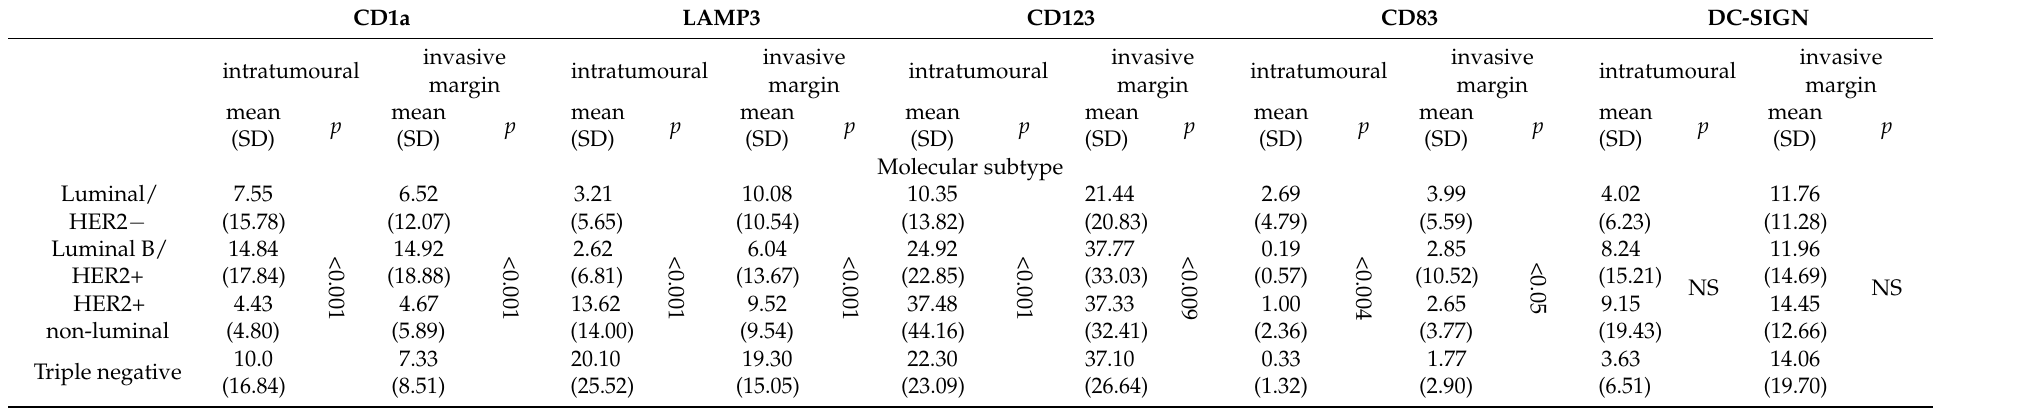
Table 3. DC density in breast cancers of different molecular